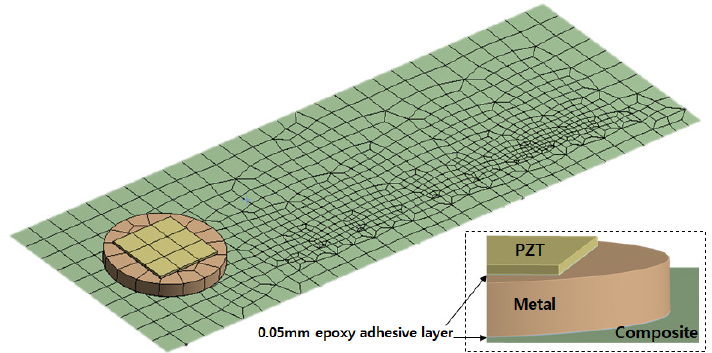
Figure 11. FEA model of the test specimen (metal disc PZT attachment method).